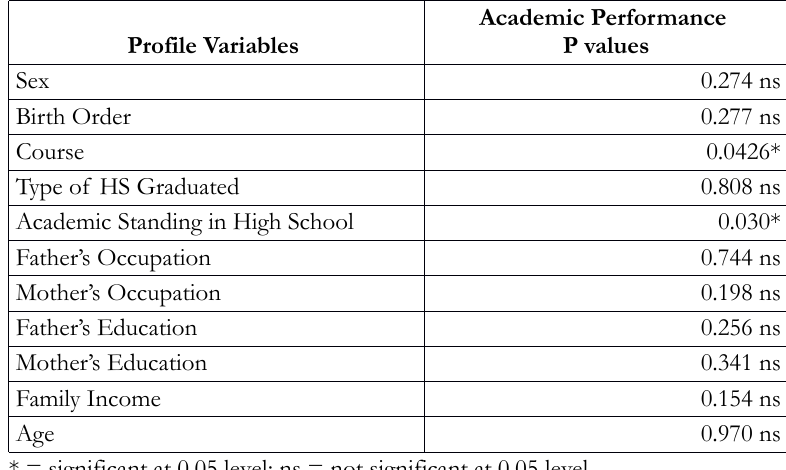
Table 5. Test of Difference on the Academic Performance of the